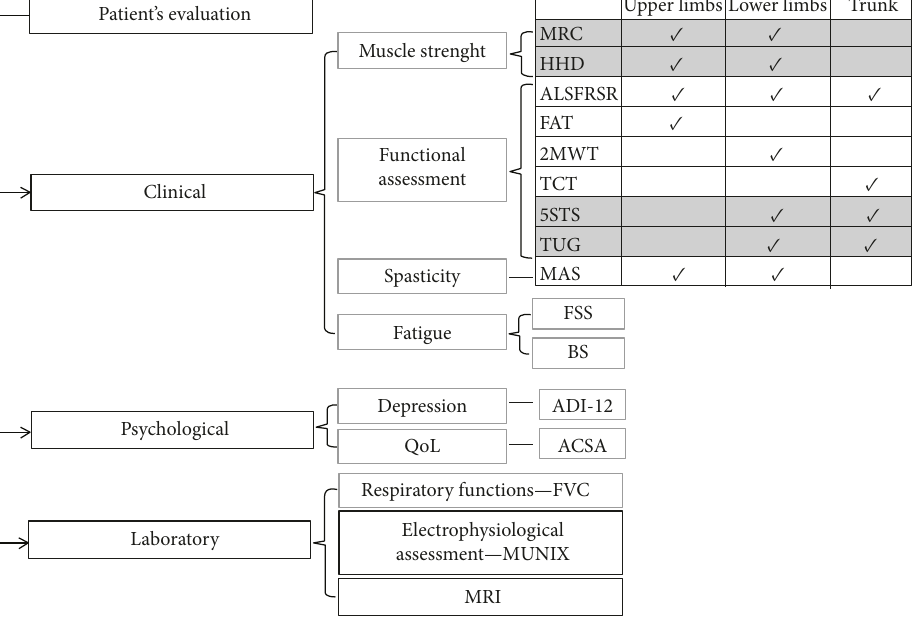
Figure 1: Patient ’ s assessment paradigm. The diagram presents the applied electrophysiological methods, psychological assessment, and functional tests, along with their assignment to speci fi c